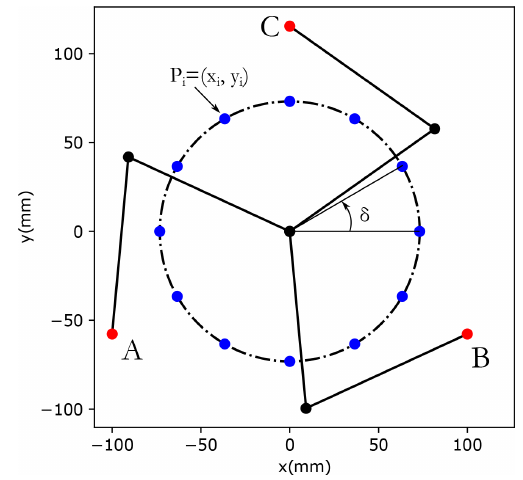
Figure 10. Discretization of the projected